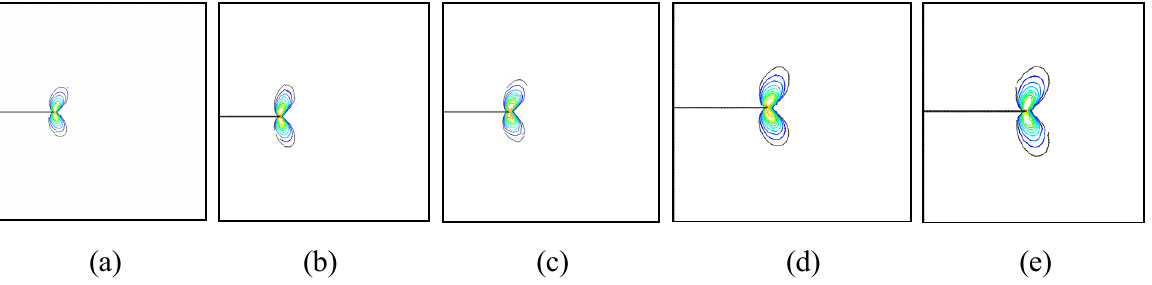
Figure 14. Shape of the plastic zone at the crack tip under plane strain: ( a ) grain gradient of 0.5; ( b ) grain gradient of 0.4; ( c ) grain gradient of 0.3; ( d ) grain gradient of 0.2; ( e ) grain gradient of 0.1.